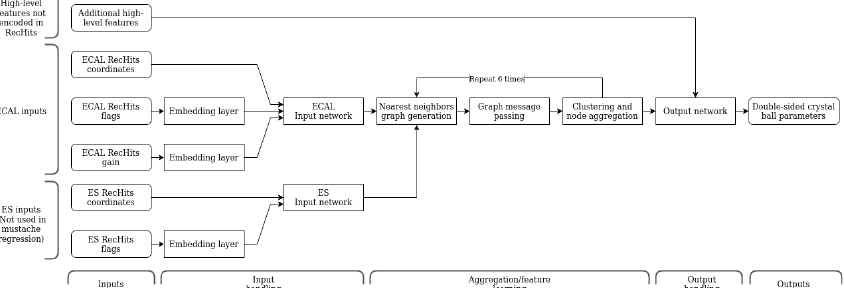
Figure 4. Flowchart of the operation of the Dynamic Reduction Network. A point cloud of rechits is mapped into a high-dimensional latent space using a fully-connected neural network, where it is then iteratively transformed and pooled using graph operations. This resulting high-level learned features are then concatenated with extra high-level information not available from the raw collection of rechits, and passed through another fully-connected neural network to obtain the regression output.